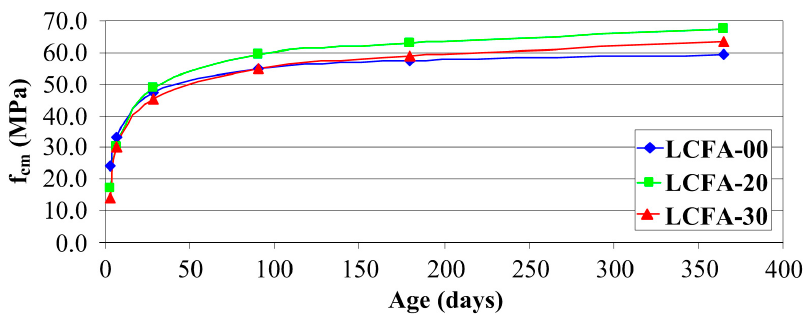
Figure 12. Compressive strengths of analyzed concretes as a function of curing time.